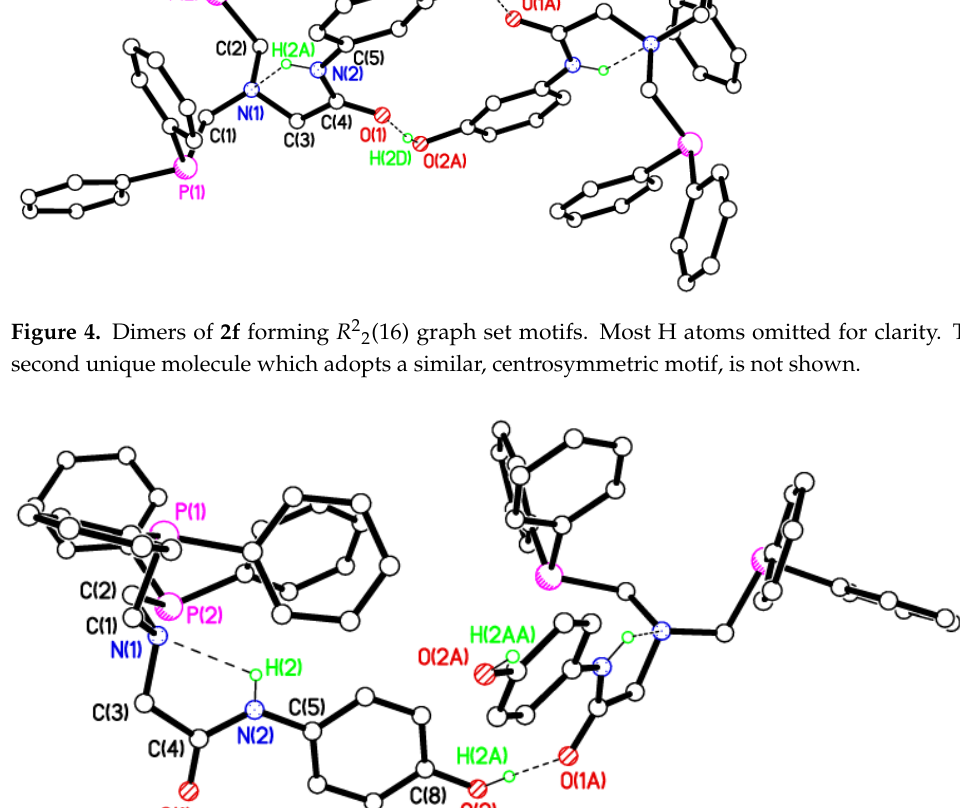
Figure 5. Intra- and intermolecular interactions in the crystal structure of 2g . Most H atoms omitted for clarity. Symmetry operator A = x, − y + 3 / 2 , z − ½.